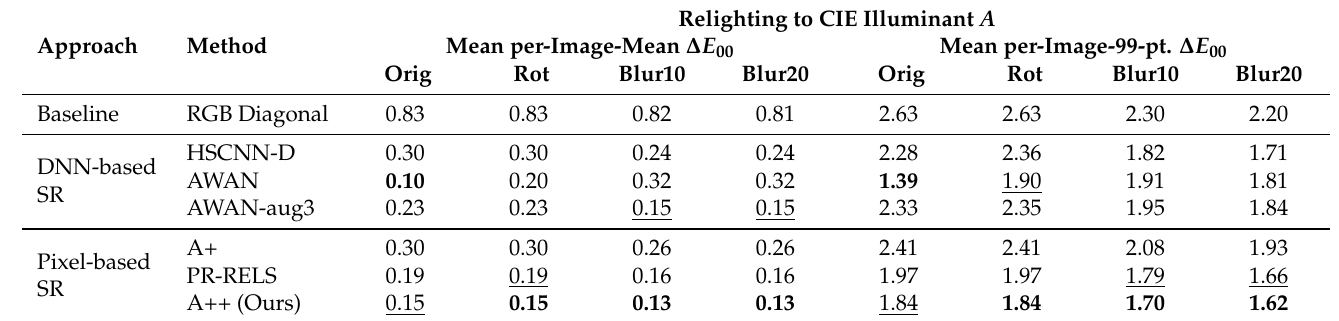
Table 6. The CIE Illuminant A relighting results. The mean results of per-image mean and 99- percentile ∆ E 00 are presented. The best methods in each experiment are marked in bold font, and the second bests are underlined.